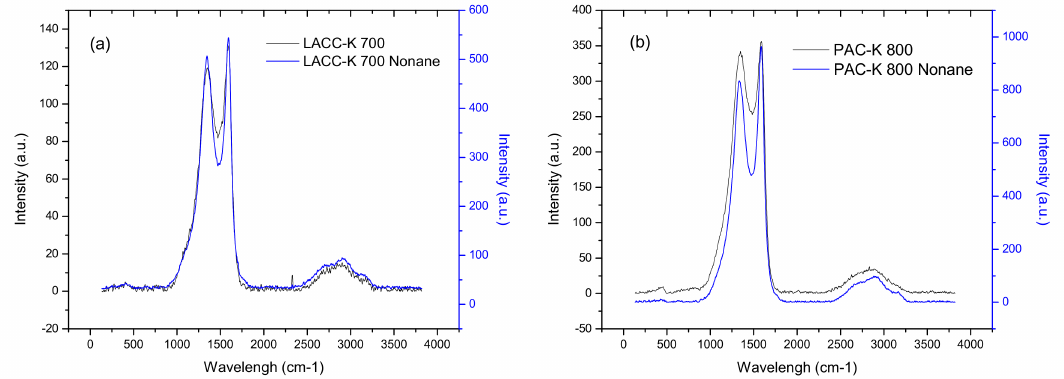
Figure 5. Raman spectra for the KOH activated carbons (( a ) LACC-K 700 and ( b ) PAC-K 800) before and after incorporation of